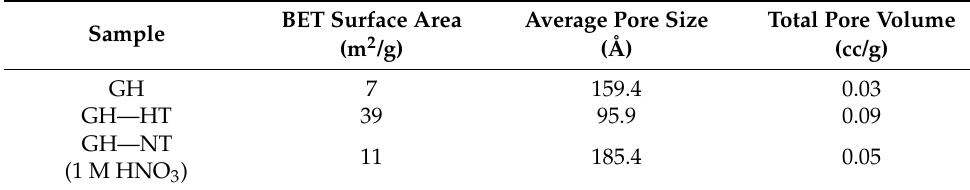
Table 4. Physical characteristics of untreated and treated graphite.